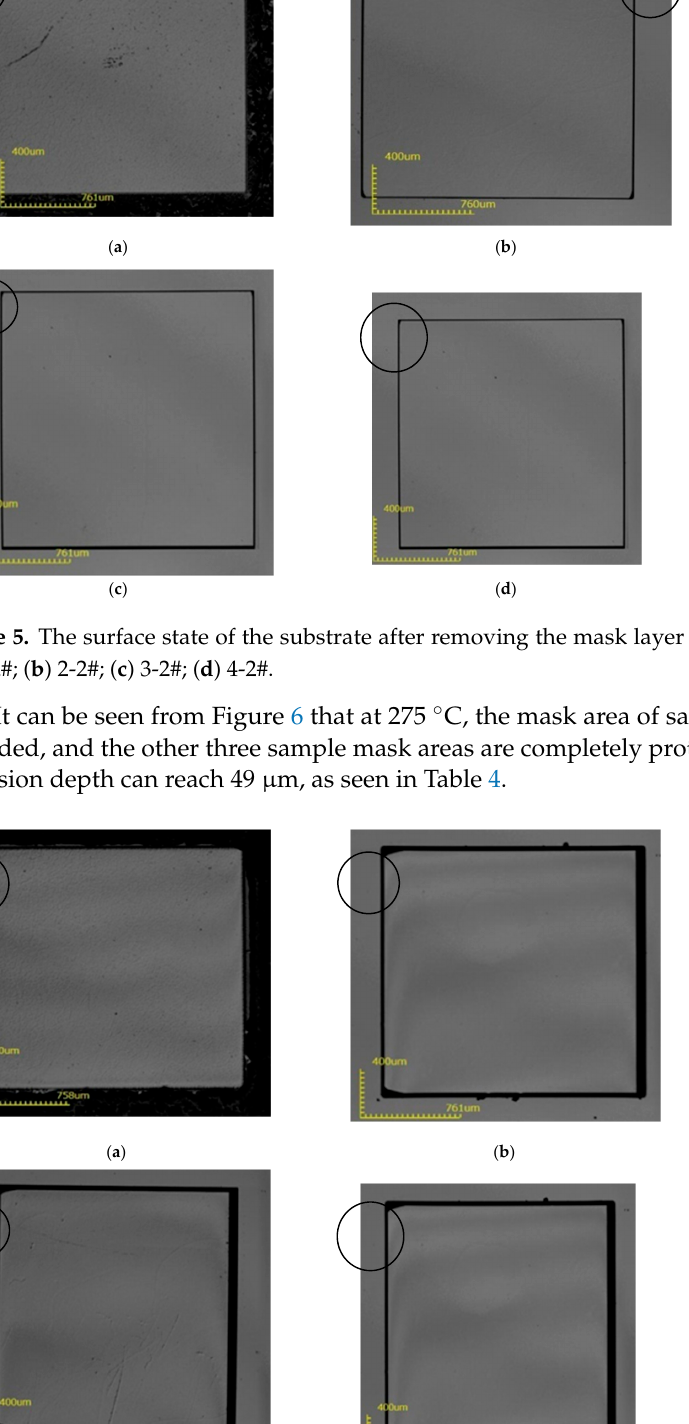
line in the figure. The wider the black line, the greater the corrosion depth; and the thinner the black line, the smaller the corrosion depth. At 250 °C , the corrosion depth can reach 14 μ m.